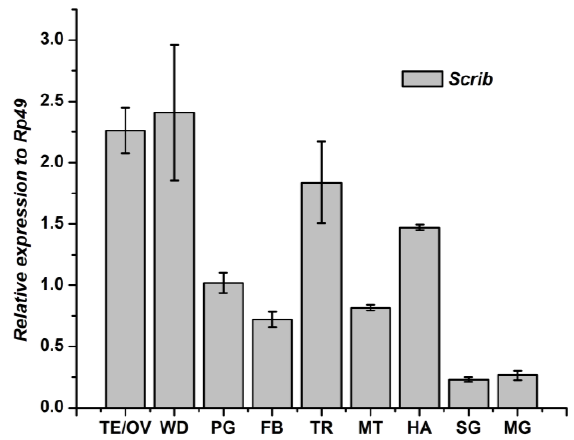
Figure 2. Tissue distribution of Scrib mRNA in Bombyx mori . fat body, FB; midgut, MT; testis/ovary, TE/OV; wingdisc, WD; trachea, TR; malpighian tubule, MG; hemolymph, HA; prothoracic gland, PG; silk gland, SG.